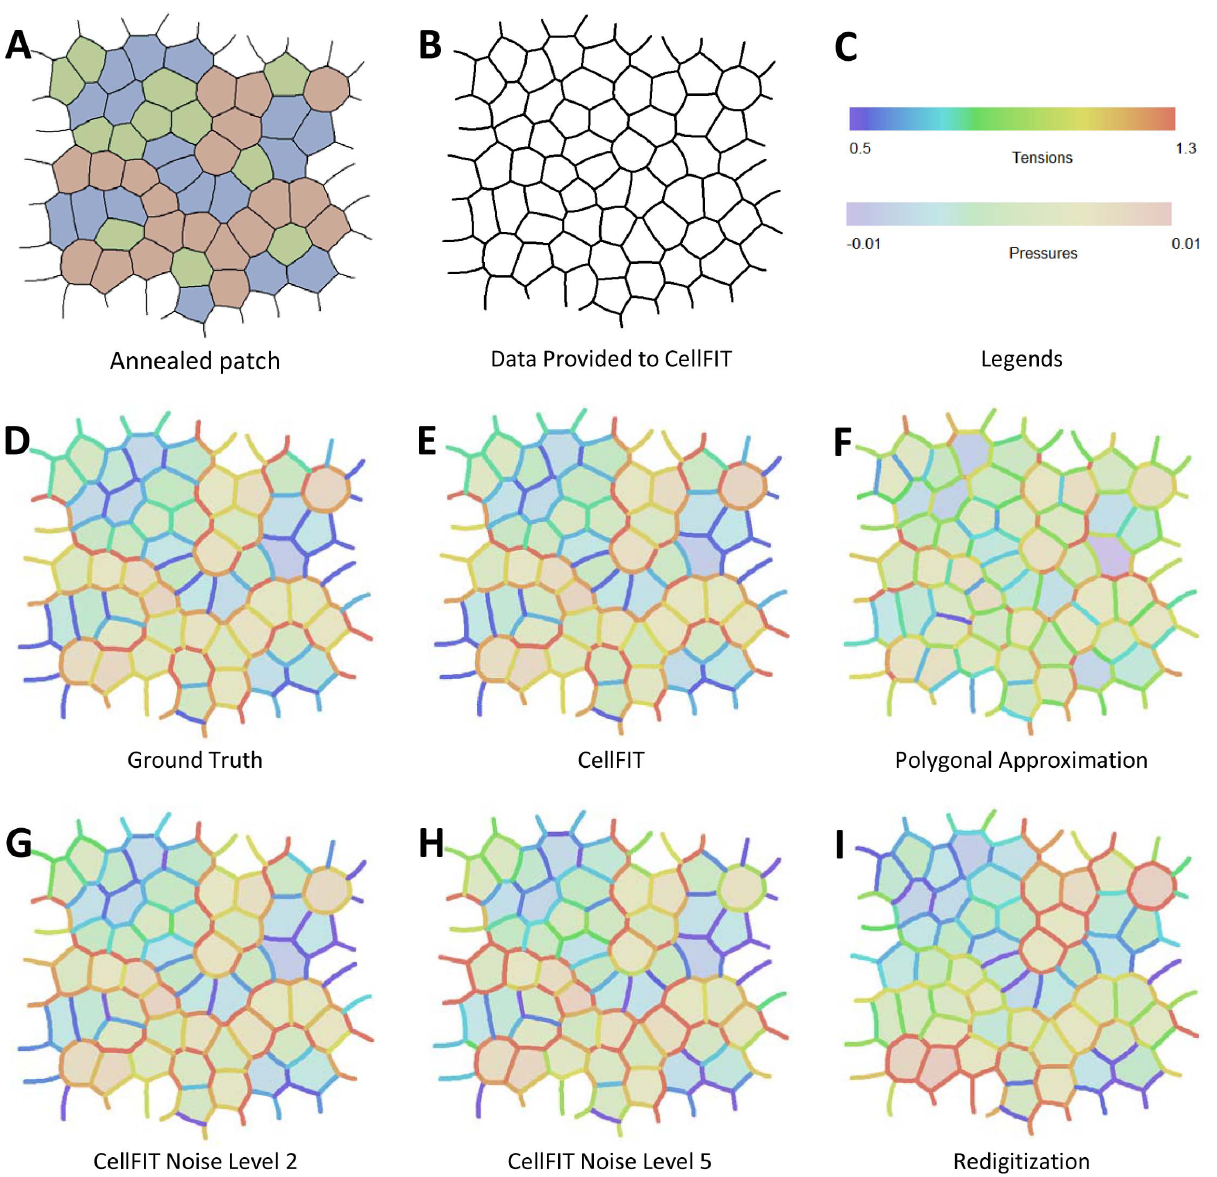
Figure 1. A synthetic planar aggregate and its analysis by CellFIT. ( A ) shows a representative region consisting of 50 complete cells, 177 complete edges, and 30 partial cells and corresponding incomplete edges taken from a larger aggregate. Its cells were assigned to one of three types, as indicated by coloured shading and a finite element model was used to determine its annealed state, as shown. The edge tensions were assigned the following values according to their type 5:6:7:10:11:12. ( B ) shows the topological and geometric information provided to the CellFIT algorithms. The spectra shown in ( C ) provide legends for the tension and pressure colours used in the remaining parts of the figure. ( D ) shows the ground truth Standard Tensions and Pressures as determined by the FE annealing process, and extracted using Equation 16 and its associated text. ( E ) shows the values that the standard Polyarc version of CellFIT calculates based solely on the data in (B). ( F ) shows the results obtained by calculating the angles at triple junctions using straight edges only. ( G ) and ( H ) show CellFIT results when noise levels of 2 or 5 are respectively introduced into the CellFIT input data. A noise level of x corresponds to x degrees of angle error and x % curvature error. ( I ) shows CellFIT results obtained after the original mesh was converted into an image and redigitized before